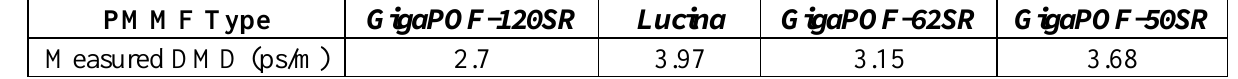
Table 2. Measured DMD as a function of the fiber type.